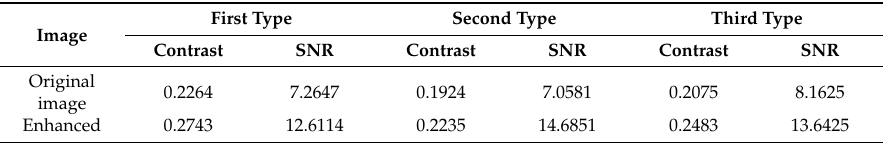
Figure 6. Different types of images (see Figure 5) with improved adaptive Multi-Scale Retinex (MSR). ( a ) First type; ( b ) Second type; ( c ) Third type. Table 1. Quantitative evaluation of froth image enhancement.